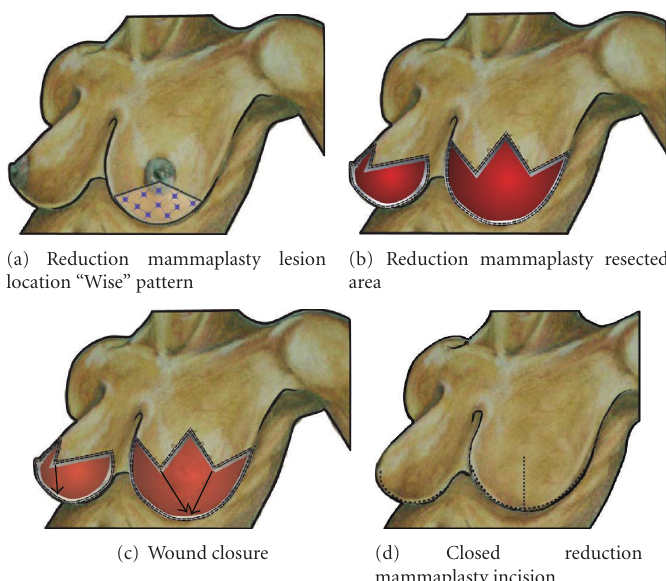
Figure 12: Reduction mammaplasty. (a) Shows multiple “stars” indicating possible tumor locations suitable for this approach. (b) Shows surgical cavity after resection of nipple-areolar complex and inferior breast using Wise pattern. A symmetrical reduction is shown in the opposite breast. (c) Shows advancement of medial and lateral pedicles to inframammary fold. (d) Shows the breasts after closure of the